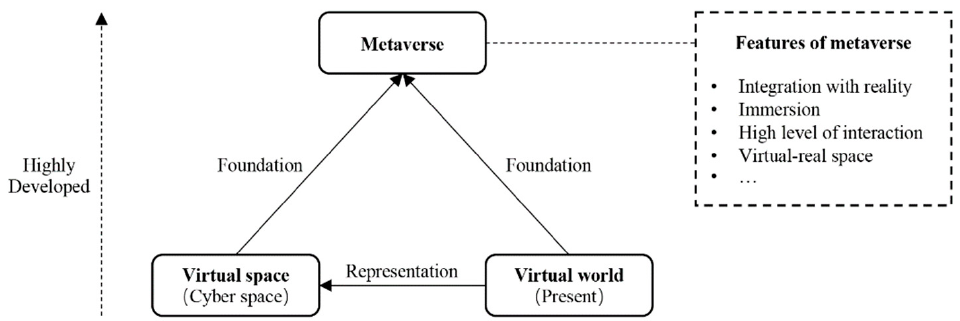
Figure 1. Relationship between metaverse, virtual space and virtual world.